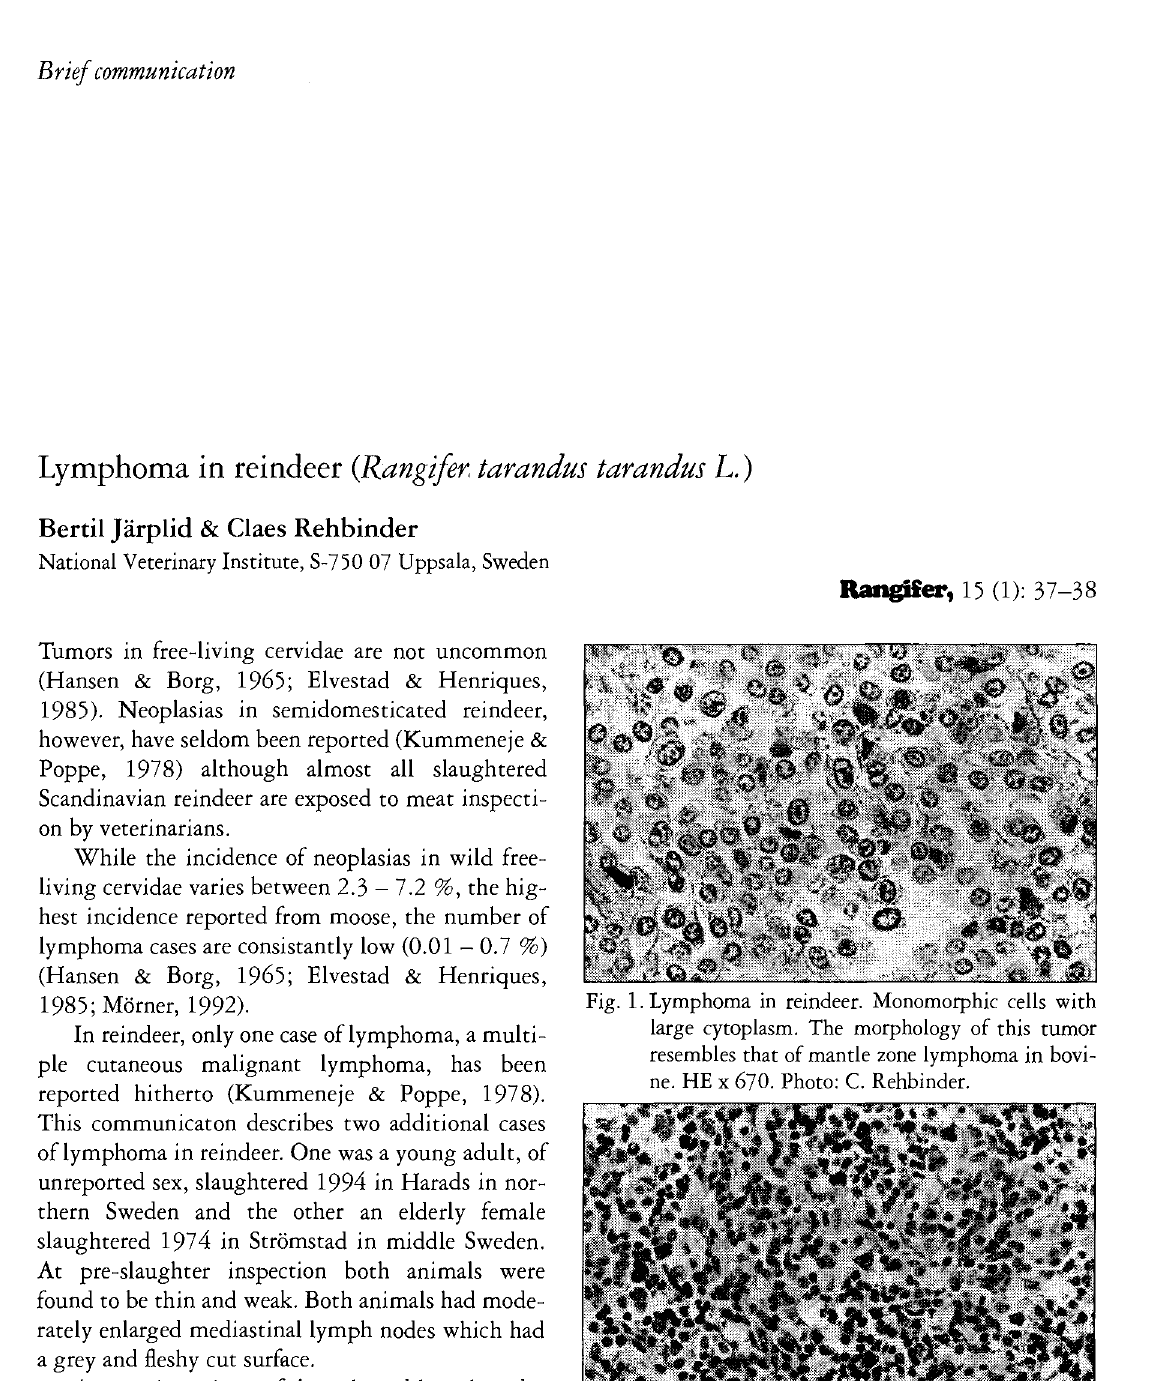
Fig. 2. Lymphoma in reindeer. Pleomorphic cells scatte red in a rather pronounced stroma. The morpholo gy of this tumor resembles that of histo-lympho- cytic lymphoma. HE x 450. Photo: B.